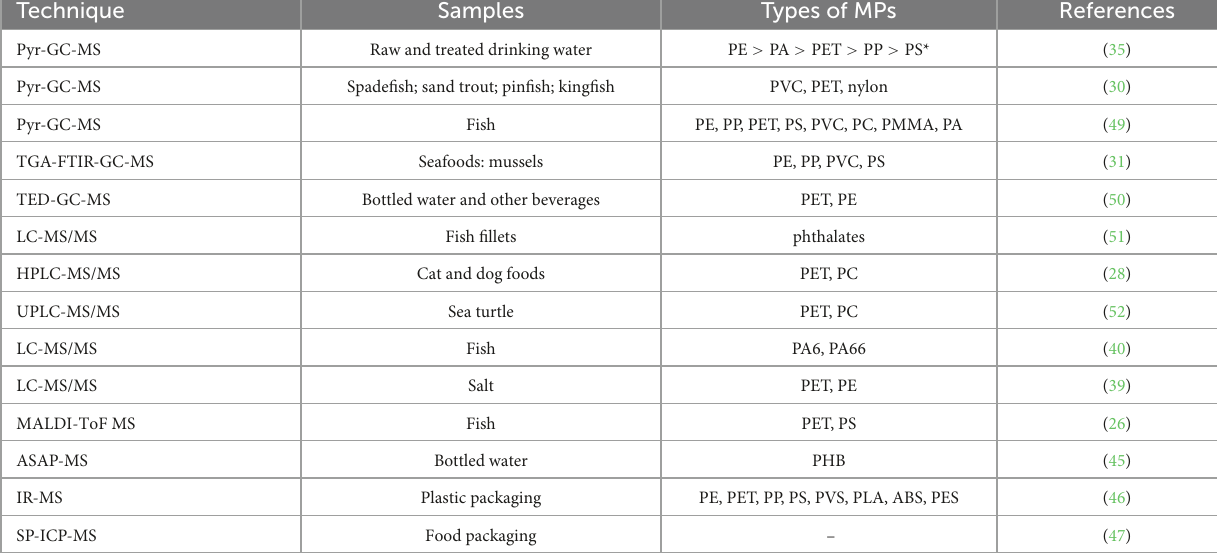
TABLE 1 The applications of gas chromatographic-mass spectrometry (GC-MS) and liquid chromatography-tandem mass spectrometry (LC-MS) in microplastics (MPs) determination. Technique